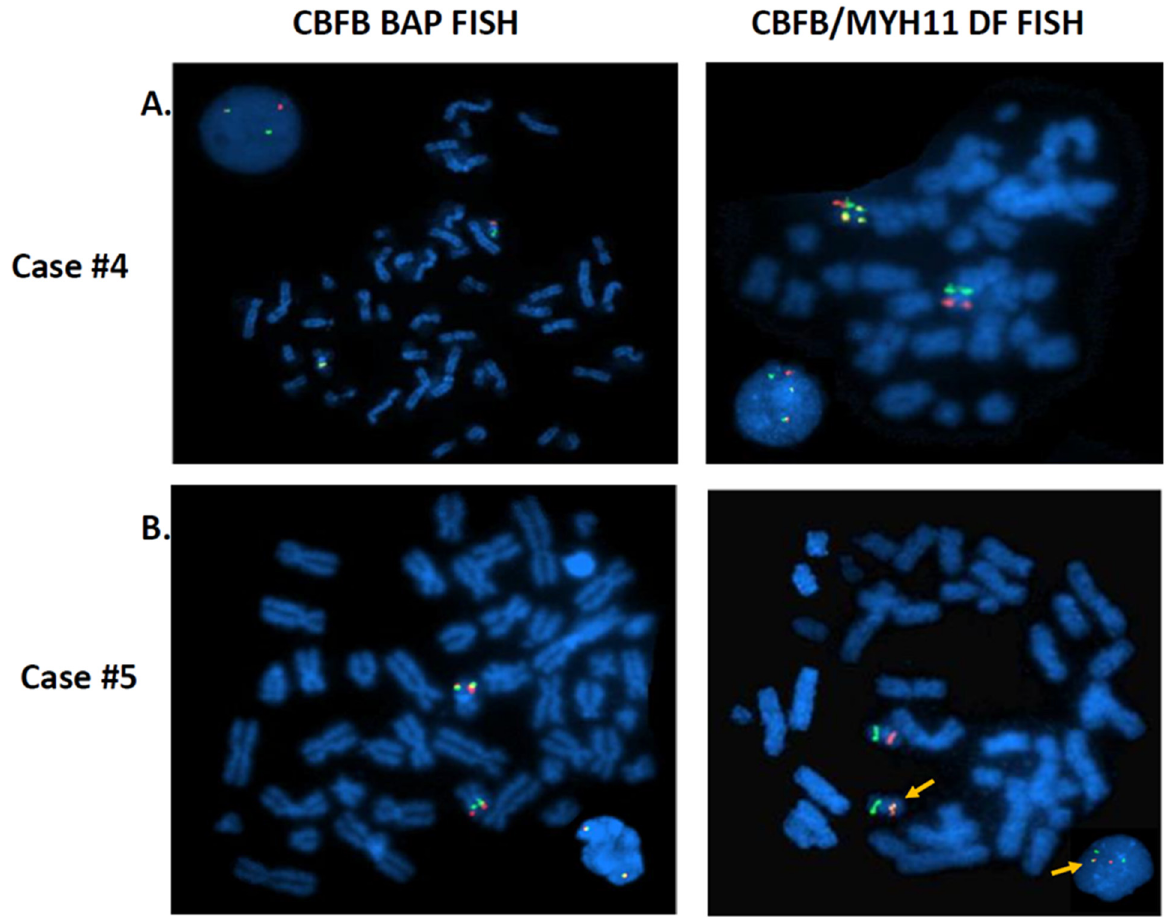
Figure 3. FISH studies with CBFB BAP FISH and CBFB-MYH11 DF FISH in two cases. ( A ). Case #4: Both BAP FISH (left, 1R1G1F signal pattern) and DF FISH (right, 1R1G2F) showed typical signal patterns for CBFB-MYH11 rearrangement. RT-PCR was negative in this case. ( B ). Case #5 showed a negative CBFB BAP FISH result (left). CBFB-MYH11 DF FISH indicated an insertion of MYH11 (green) into the CBFB (red), forming a fusion signal (right). RT-PCR was positive in this case.